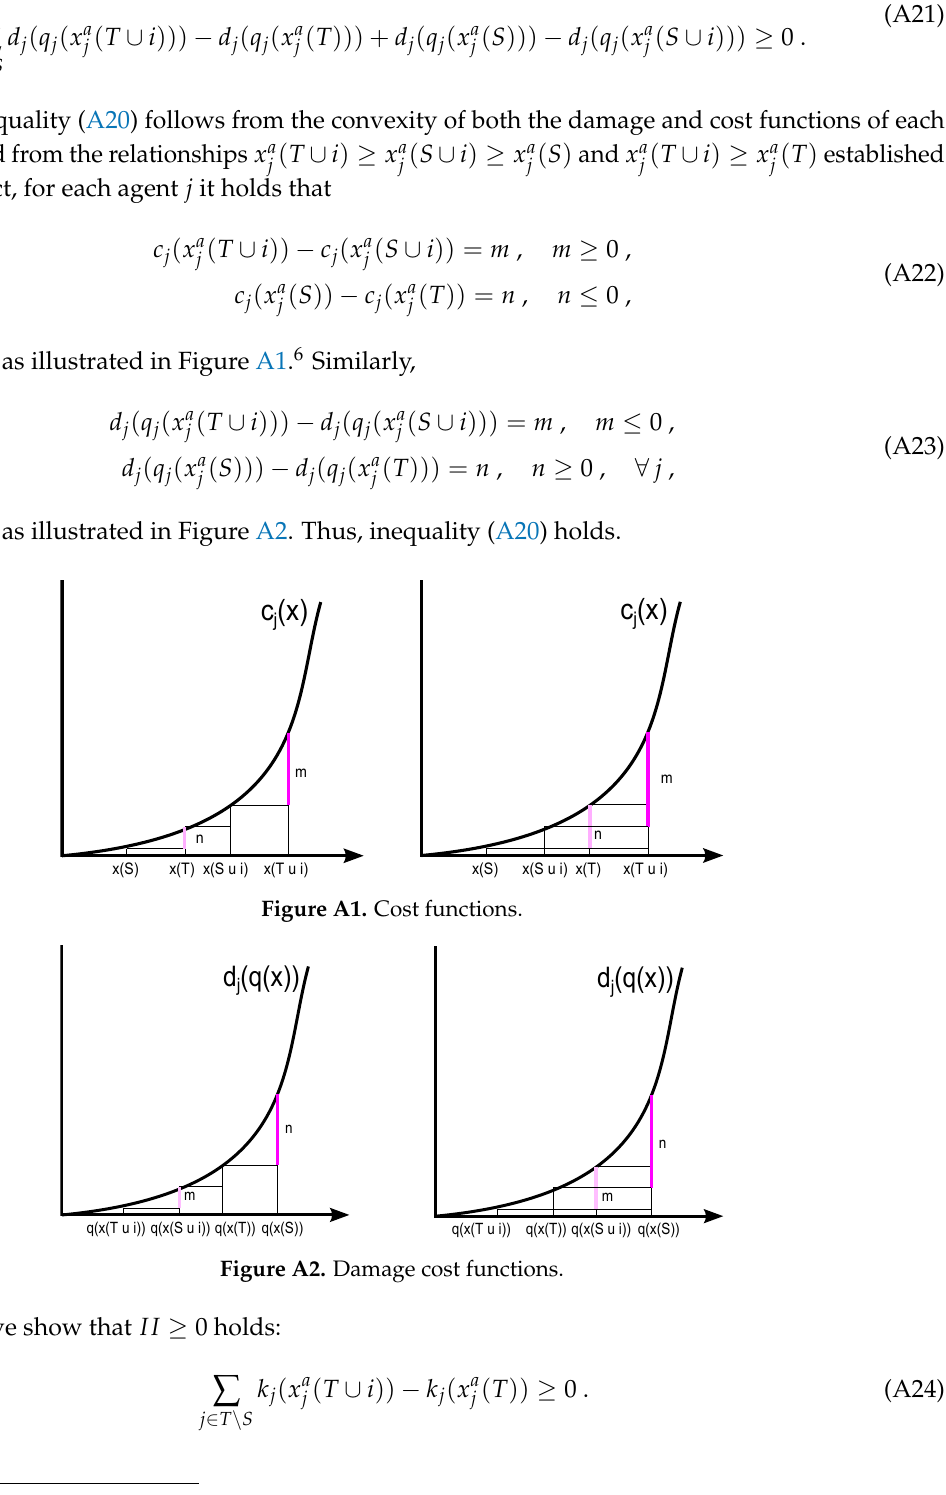
Figure A2. Damage cost